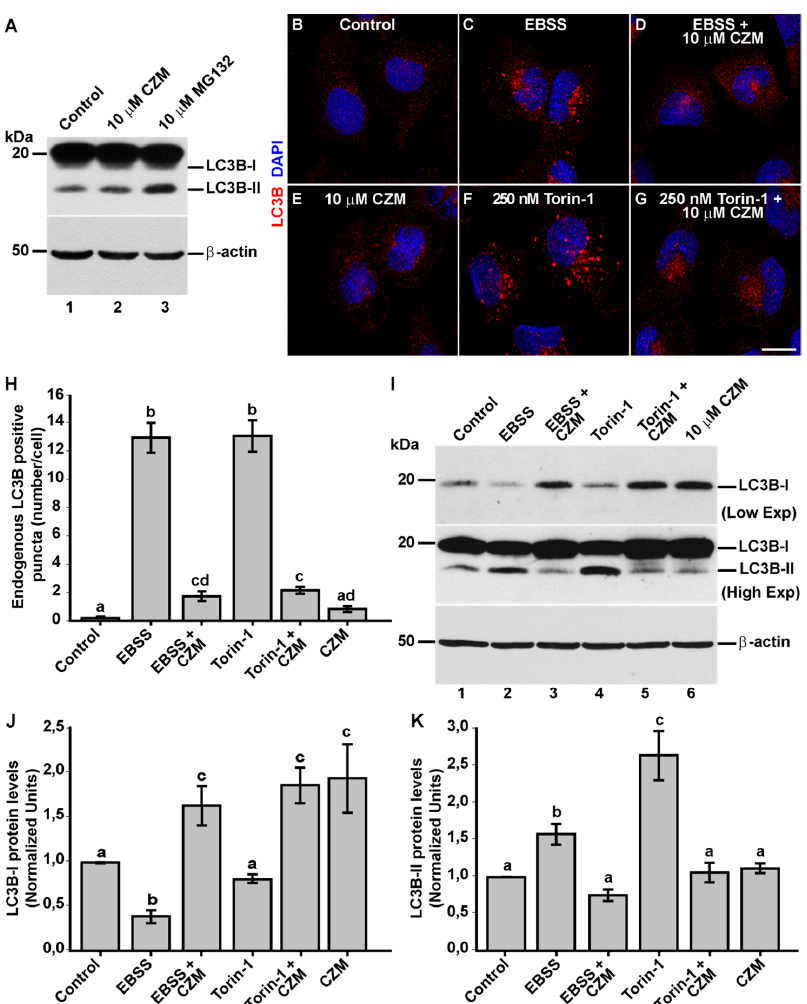
Figure 6. Inhibition of autophagosome formation by CZM. ( A ) Parental H4 cells were treated either with the vehicle (DMSO; Control), CZM for 4 h or MG132 for 6 h and protein extracts were analyzed by western blot with a polyclonal antibody to LC3B. Monoclonal antibody to β -actin (clone BA3R) was used as a loading control. The positions of the molecular mass markers are indicated on the left. Immunofluorescence microscopy analysis of the subcellular localization of endogenous LC3B in parental H4 cells treated with either the vehicle (DMSO; Control) ( B ), EBSS for 4 h ( C ), CZM for 6 h ( E ) or Torin-1 for 4 h ( F ). EBSS ( D ) and Torin-1 ( G ) were tested using a 2-h pretreatment with CZM followed by the treatment with EBSS or Torin-1 for 4 h in the presence of CZM. Cells were fixed, permeabilized and stained with a rabbit polyclonal antibody to LC3B followed by Alexa-594-conjugated donkey anti-Rabbit IgG, and nuclei were stained with DAPI. Scale bar 10 µ m. ( H ) Quantification of the puncta positive to LC3B. Statistical significance was determined by one-way ANOVA, followed by Tukey’s test. Bars represent the mean ± SEM ( n = 50 cells). Di ff erent letters above the mean bars indicate the significant di ff erences between groups p < 0.05. ( I ) Protein extracts from parental H4 cells treated as in ( B – G ) were analyzed by western blot with a rabbit polyclonal antibody to LC3B. Monoclonal antibody to β -actin (clone BA3R) was used as a loading control. The position of molecular mass markers is indicated on the left. ( J ) Densitometric quantification of LC3B-I levels and ( K ) LC3B-II levels. Statistical significance was determined by One-Way ANOVA, followed by Tukey’s test. Bars represent the mean ± SEM of biological replicates (LC3B-I n = 3; LC3B-II n = 3). Di ff erent letters above the mean bars indicate the significant di ff erences between groups p <